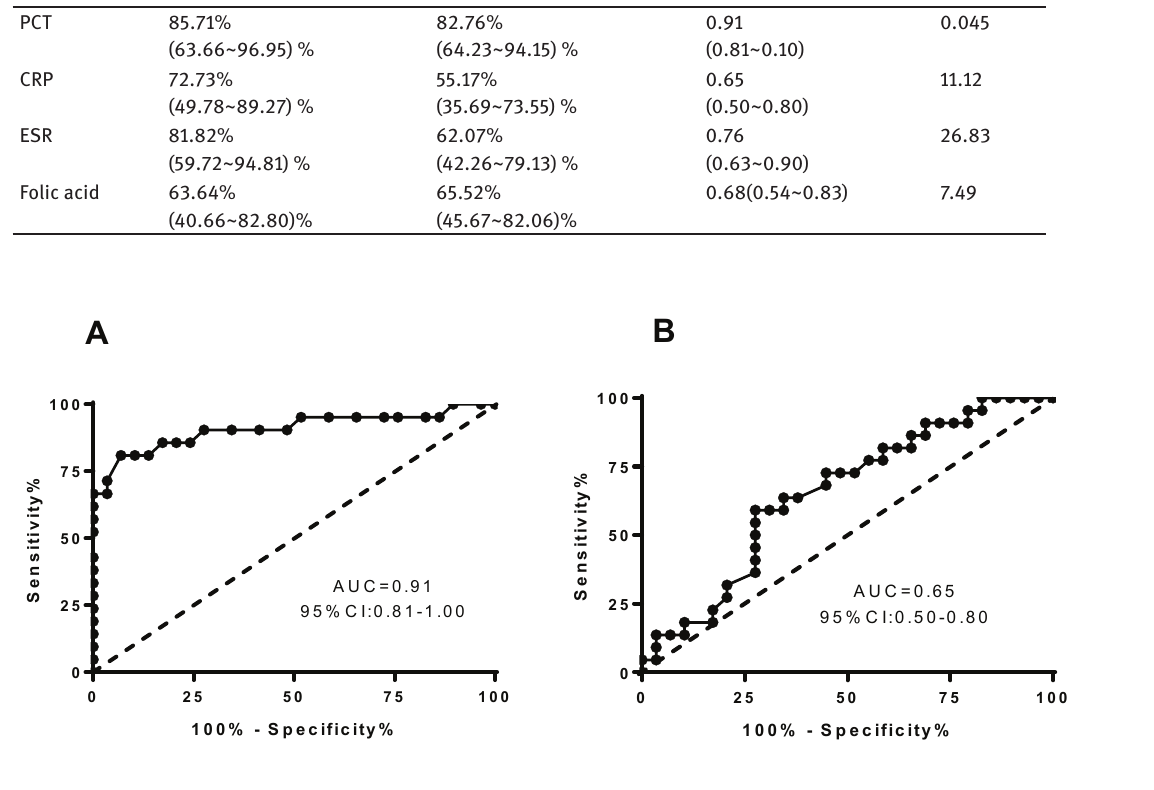
Table 2Ł The differentiation efficacy by serum PCT, CRP and ESR as biomarker. Reference